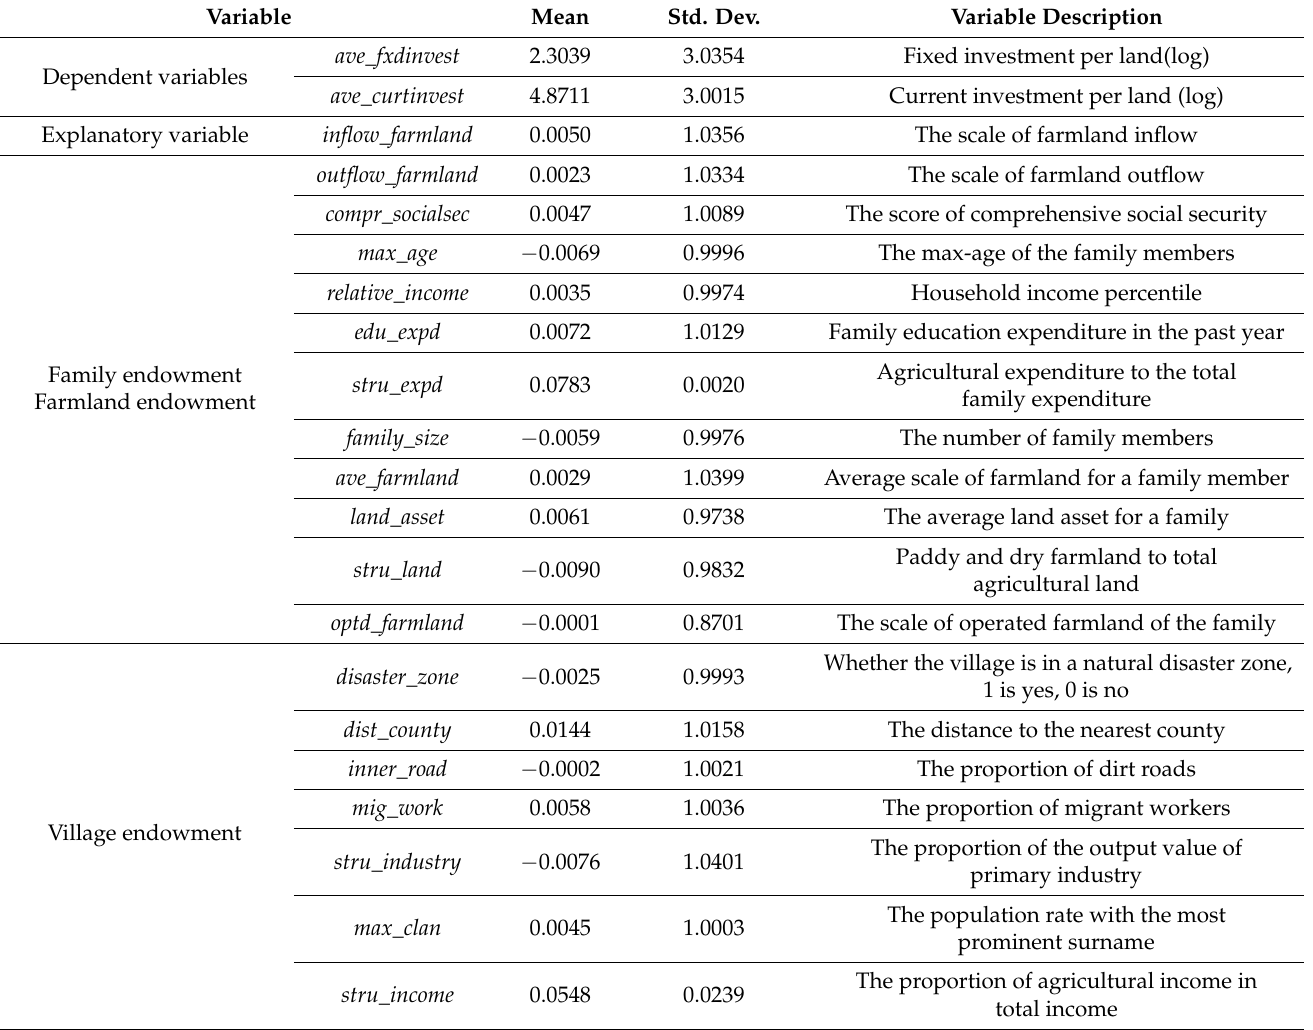
Table 1. The description of